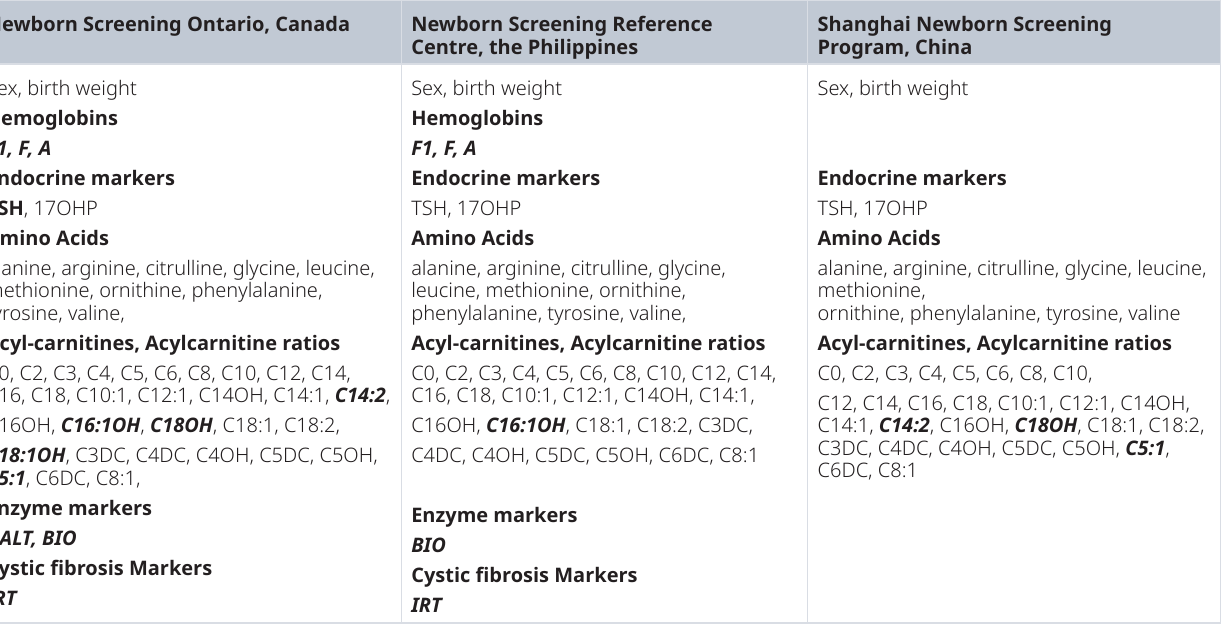
Table 1. Newborn screening data used in model